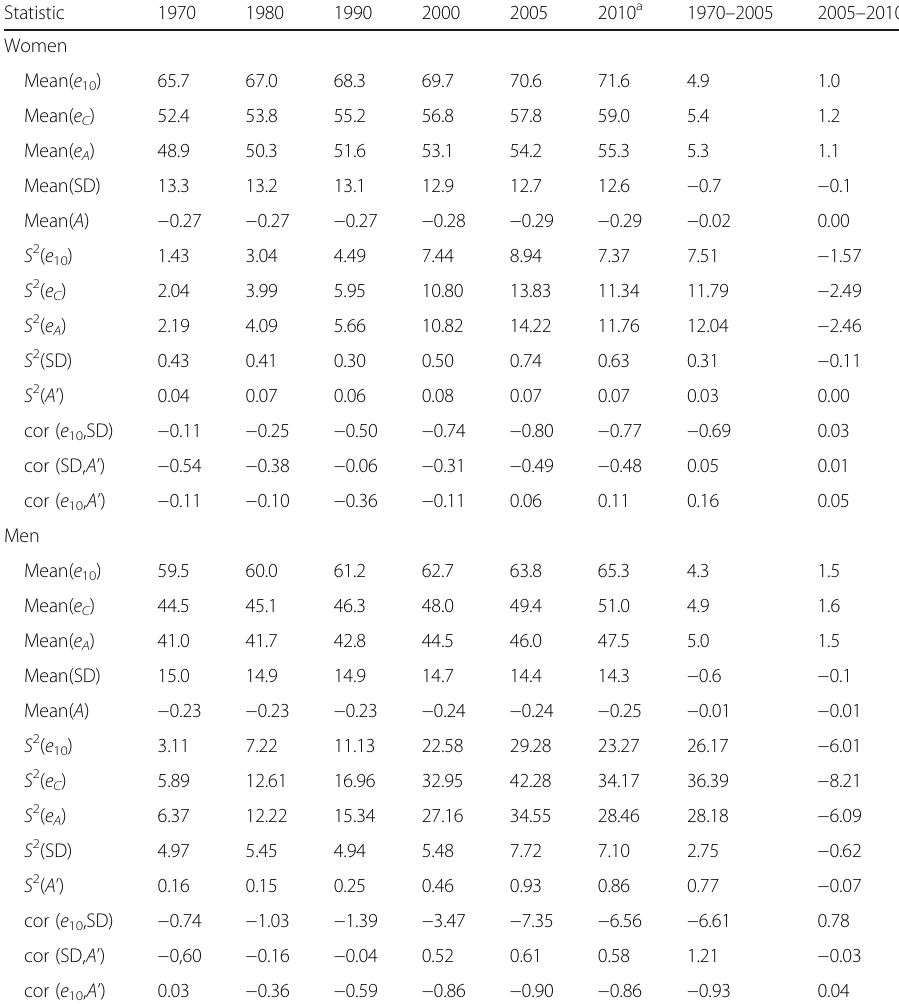
Table 1 Mean and variance ( S 2 ) of the summary measures of the life-table age-at-death distributions ( e 10 , e C , e A ) and mean, variance and covariance of its components (dispersion SD, and skewness A ’ ) across 35 developed countries, by sex. Selected years between 1970 and 2010, and absolute